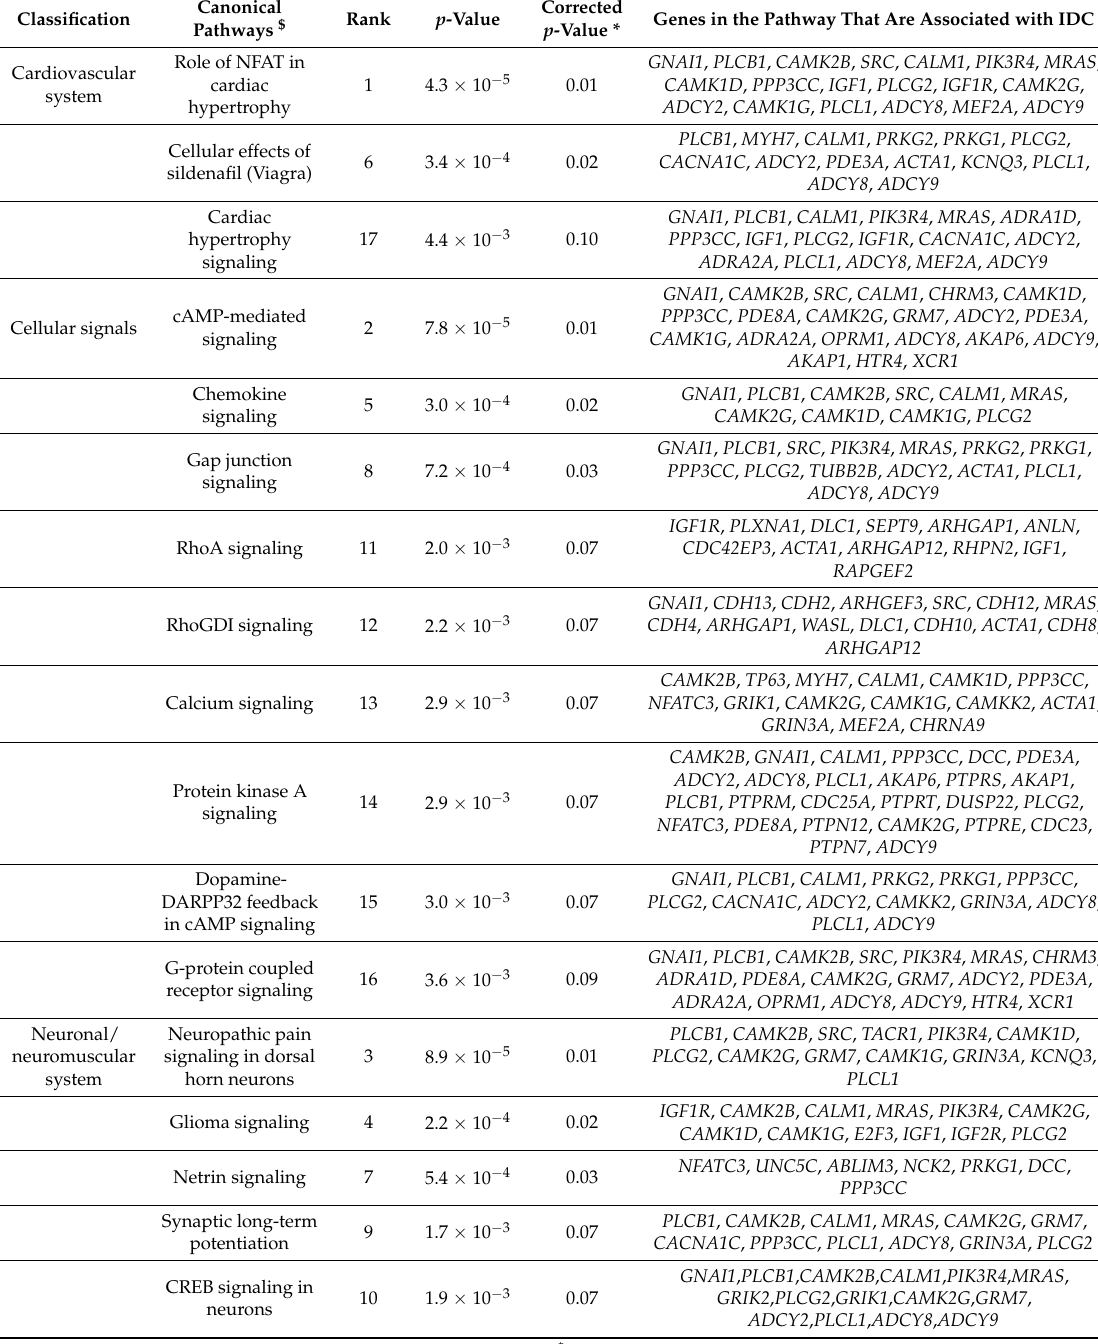
Table 2. Canonical pathway analysis on the top 1000 genomic loci associated with idiopathic dilated cardiomyopathy (IDC) using the Ingenuity database. Pathways with enrichment p < 0.1 after corrected for multiple testing are shown here, and are grouped by tissue